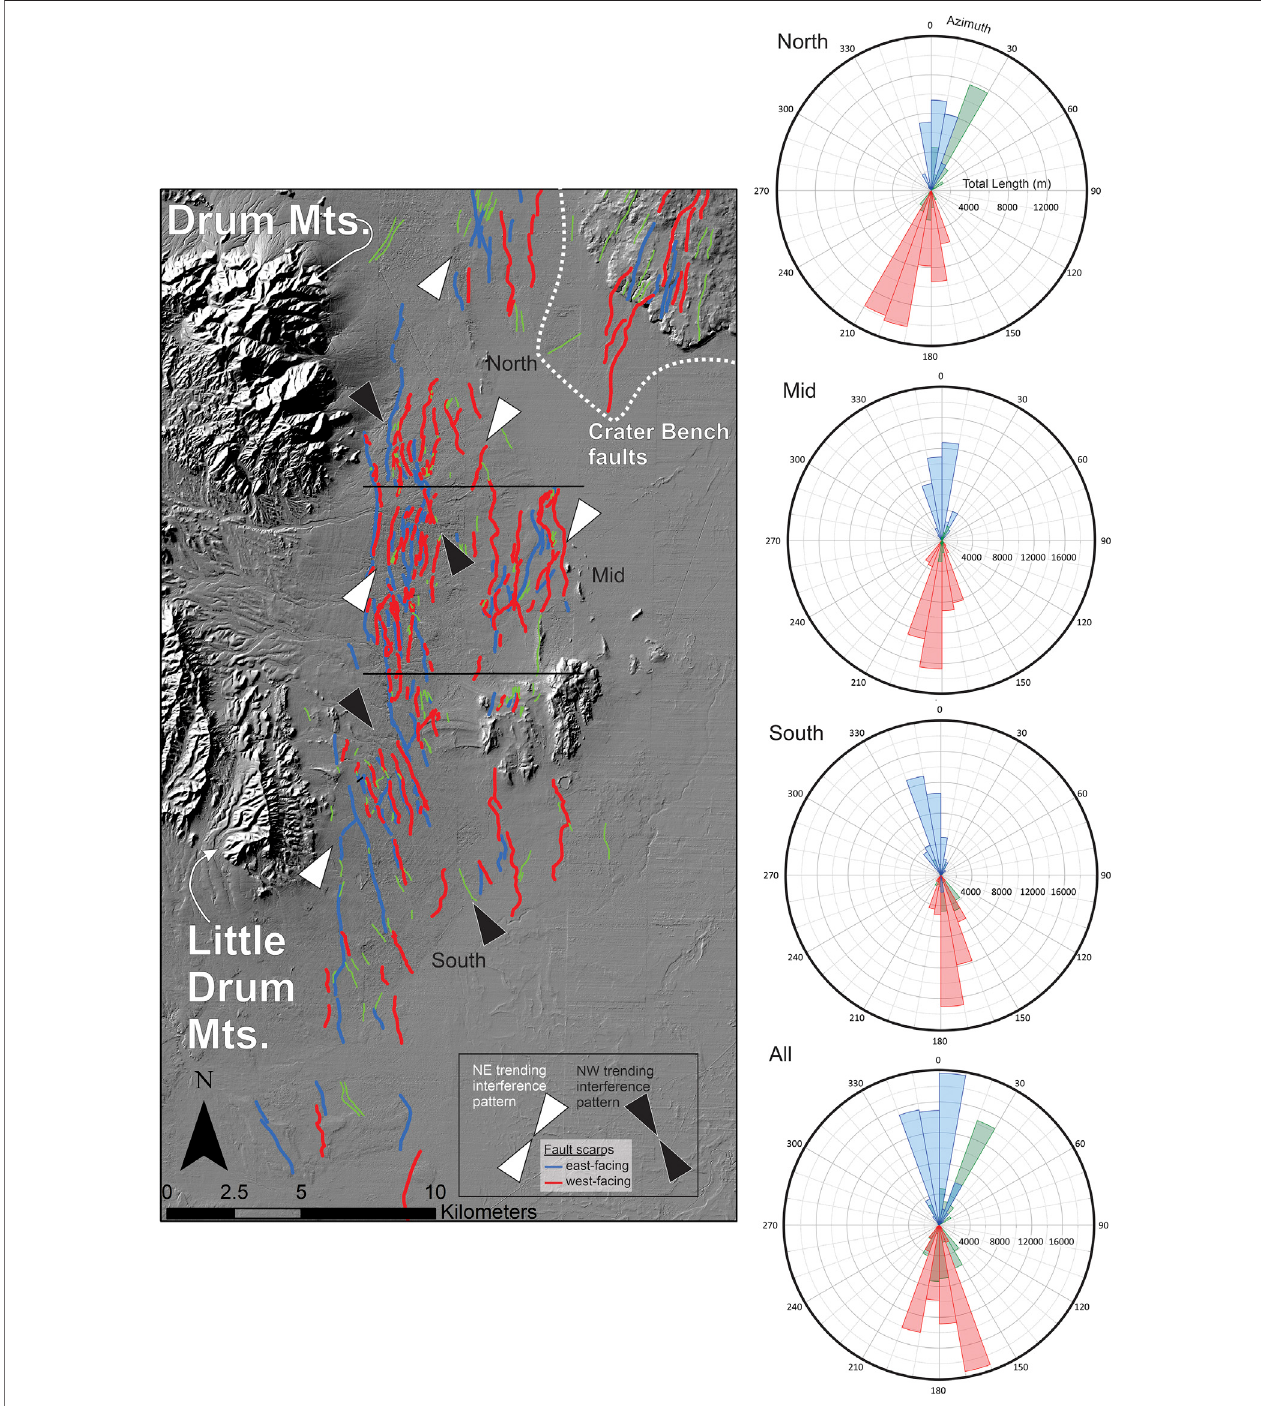
FIGURE7| Rosediagramsofstrikes(forfaultswithdipdirections,blueandred)andtrends(forsuspectedfaults,green)offaults/faulttracesintheDrumMountains fault zone. In each, the trends of suspected fault traces should be considered symmetric about the x-axis. East-facing faults (blue) and west-facing faults (red) are assigned strikes based on the dip direction. We arbitrarily created three sections to the DMFZ — North, Mid, and South — based on a qualitative assessment of the fault patterns along strike. For example, the boundary between North and Mid sections was speci fi ed based on the apparent “ die out ” of the eastern branch of faults in thecentral part ofthefaultzone. Ananalysisofallthree sectionsispresented inthebottomdiagram. Blackandwhitearrows highlightinterferencepatternofNWandNE oriented fault sets, respectively. Note that the cumulative lengths of east and west-dipping faults are approximately equal over the fault zone.